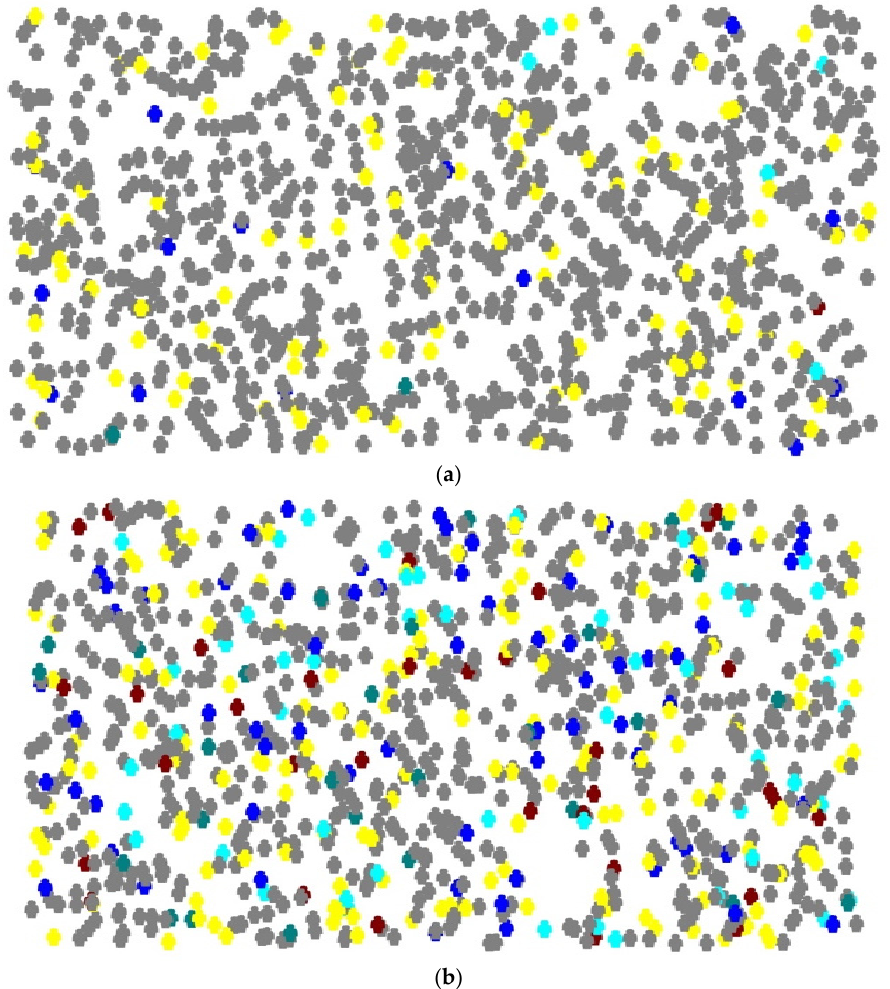
Figure 6. ( a ) Simulation’s population allocation with 10,000 agents during 180 days. Day 12. ( b ) Population allocation of 10,000 agents during 180 days. Day 71. ( b ) Population allocation of 10,000 agents during 180 days. Day